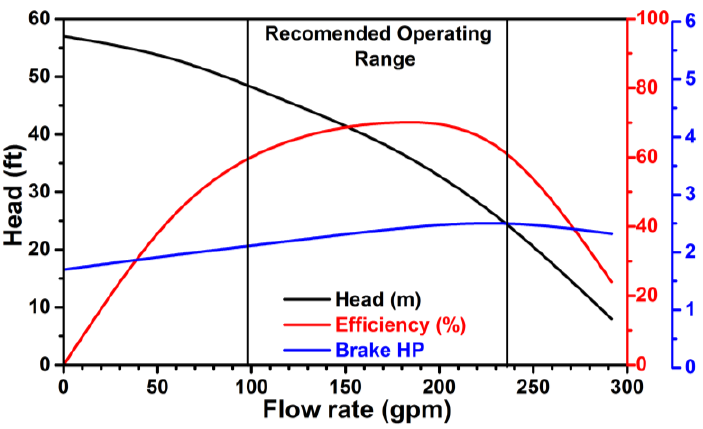
Figure 3. Hydraulic pump performance curve with water as working fluid [9].